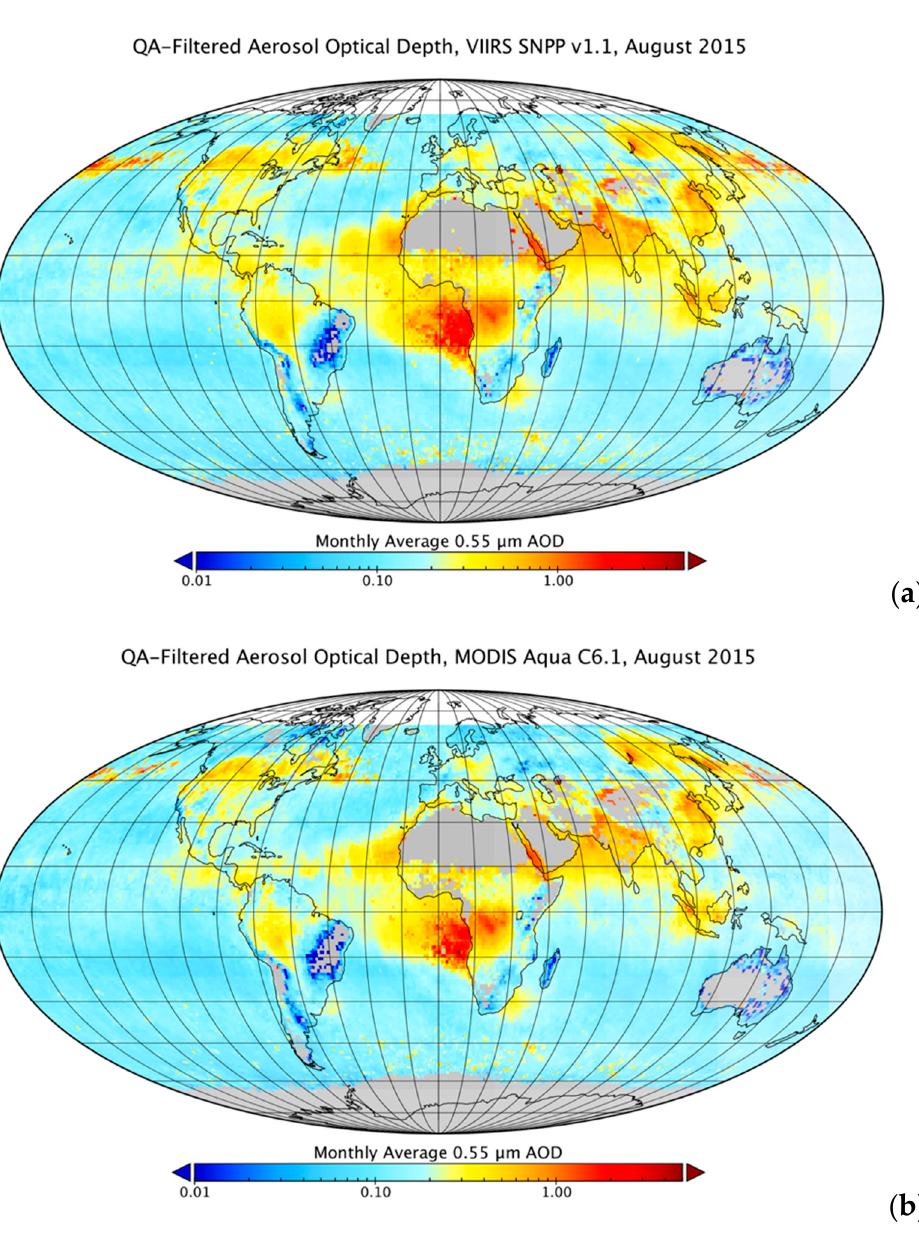
Figure 6. Monthly average quality-assurance (QA)-filtered 0.55 µ m AOD for August 2015, from ( a ) VIIRS and ( b ) MODIS. The global mean AOD values are 0.21 and 0.19, respectively.